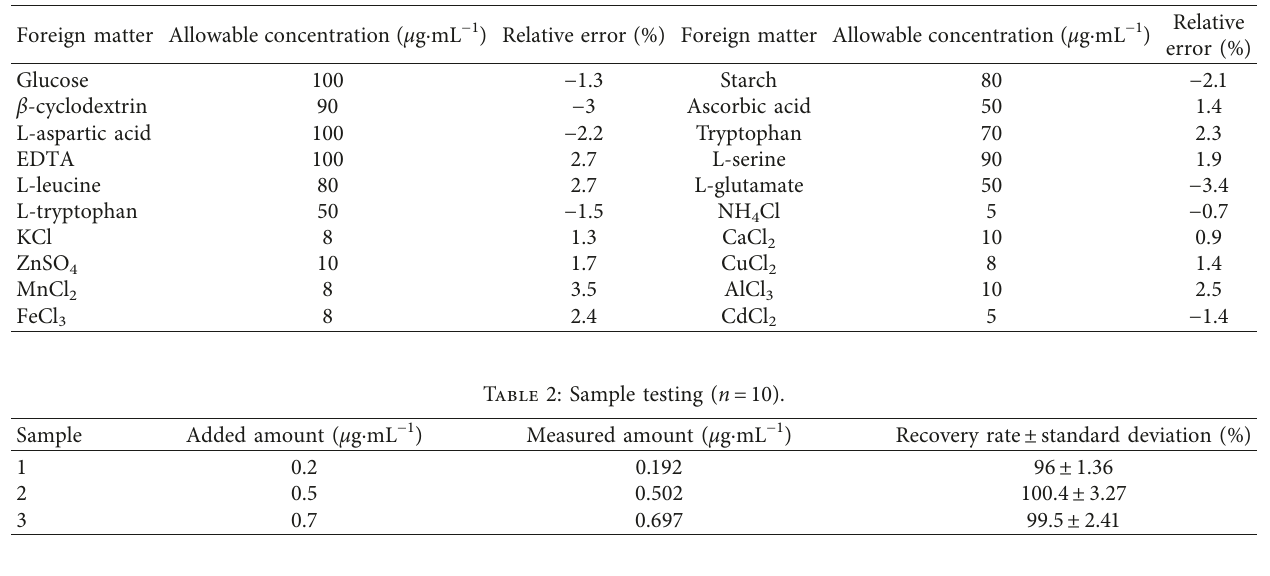
Table 1: Foreign substance allowances.